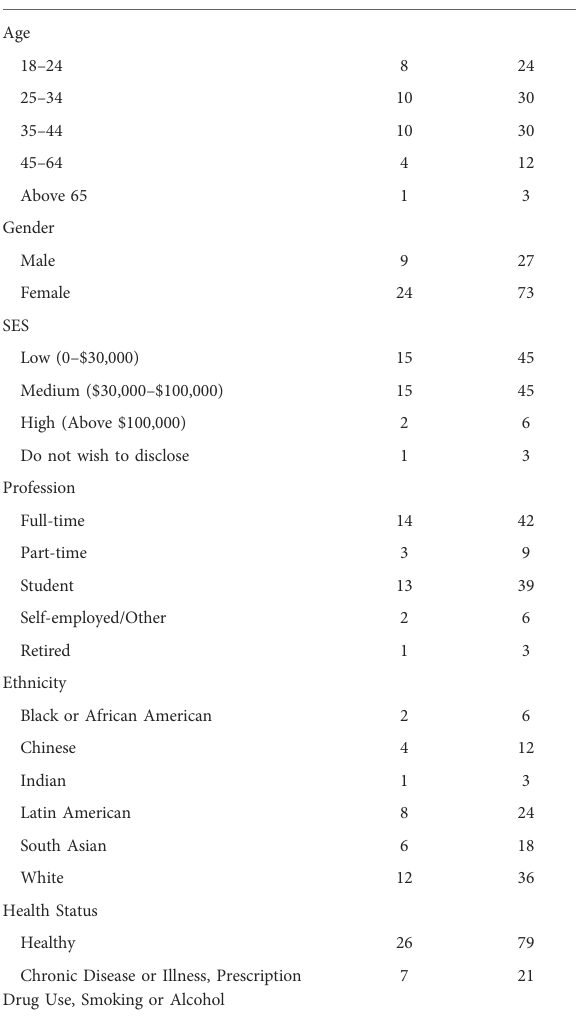
TABLE 1 Study population